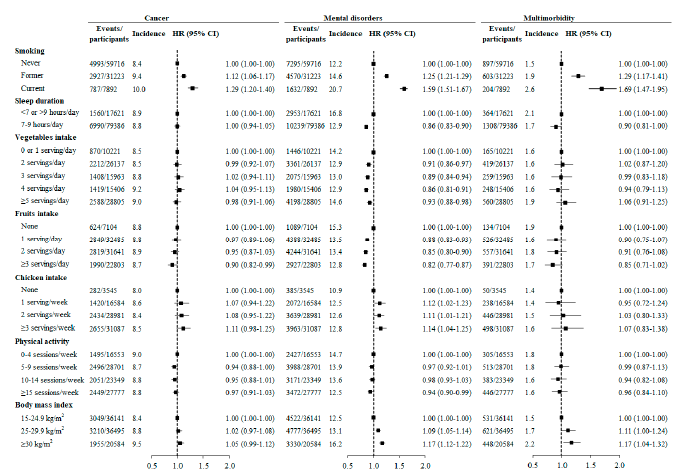
Figure 3. Hazard ratios for incident cancer, mental disorders, and multimorbidity associated with behavioral factors after multiple imputation of missing values in covariates. Hazard ratios were assessed using Cox regression models adjusted for age, gender, the country of birth, income, education, work status, number of children, BMI, psychological distress, hypertension, dyslipidemia, diabetes, asthma, arthritis, hip replacement, and family history of cancer, depression, heart disease, stroke, diabetes, hypertension, Parkinson’s disease, and dementia. As a minimal di ff erence in HRs (95% CIs) before and after multiple imputation of missing values in covariates was observed, we only present the results after multiple imputation in this